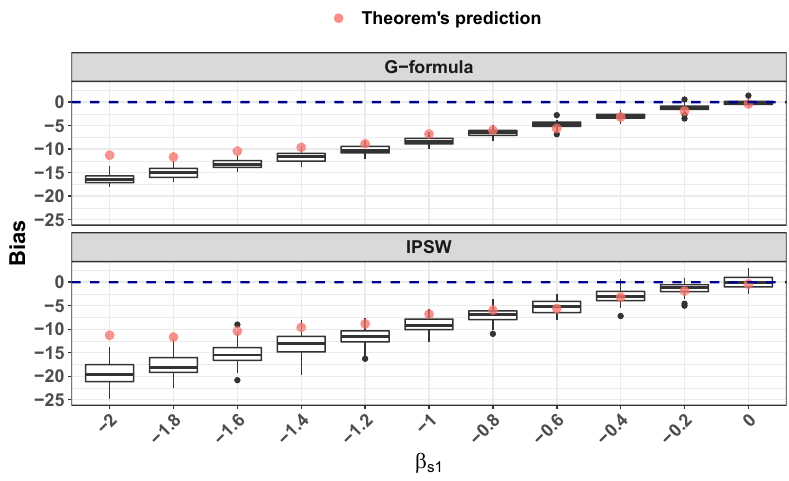
Figure 7: Impact of poor transportability of the variance – covariance matrix which is simulated with a decreasing coe ffi cient , responsible of the covariate shift between the RCT sample and the observational sample. The lower β β s ,1 absolute empirical bias ( boxplots ) , and the higher the di ff erence between the predictions given by Theorem 1 ( orange dots ) compared to the e ff ective empirical biases ( boxplots )